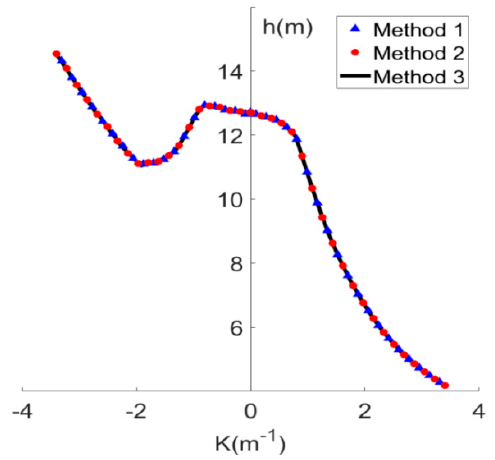
Figure 10. Bending moment in CASE 3.